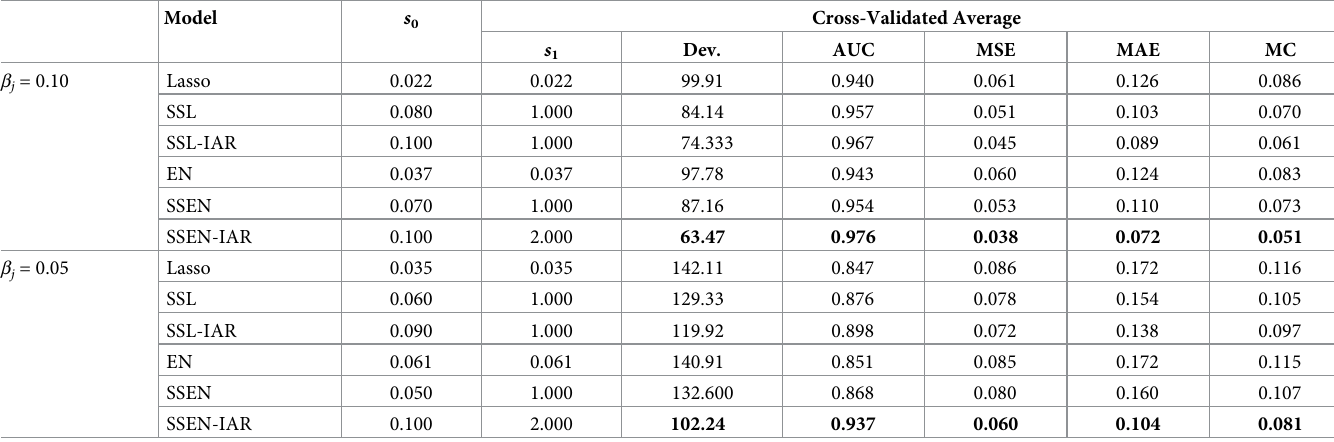
Table 3. Simulation study: Average prediction error estimates.